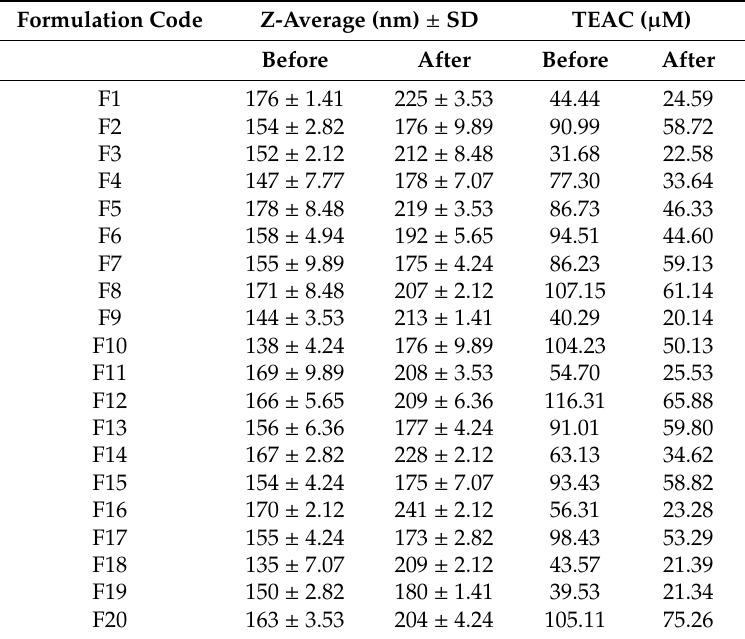
Table 2. Changes in particle size and trolox equivalent antioxidant capacity (TEAC) of the prepared liposomes before and after exposure to UV light (280–320 nm) for 6 h.